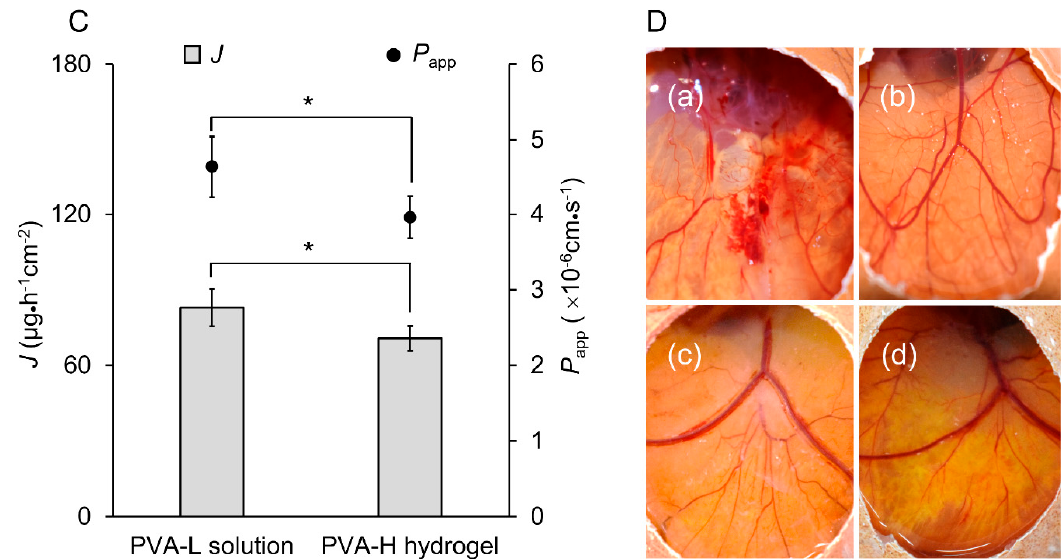
Figure 5. ( A ) Percentage of mucoadhesion of PVA-L solution, PVA-L hydrogel and PVA-H hydrogel (mean ± S.D., n = 3) (* p < 0.05); ( B ) in vitro release study of VCZ from PVA-L solution and PVA-H hydrogel (mean ± S.D., n = 3); ( C ) permeation flux ( J ) and apparent permeability coefficient ( P app ) of VCZ-loaded PVA-L solution and PVA-H hydrogel through the porcine cornea (mean ± S.D., n = 4) (* p < 0.05); ( D ) images of HET-CAM at 5 min post-instillation for the different samples; ( a ) sodium hydroxide (C+); ( b ) sodium chloride (C-); ( c ) PVA-L solution; and ( d ) PVA-H hydrogel.